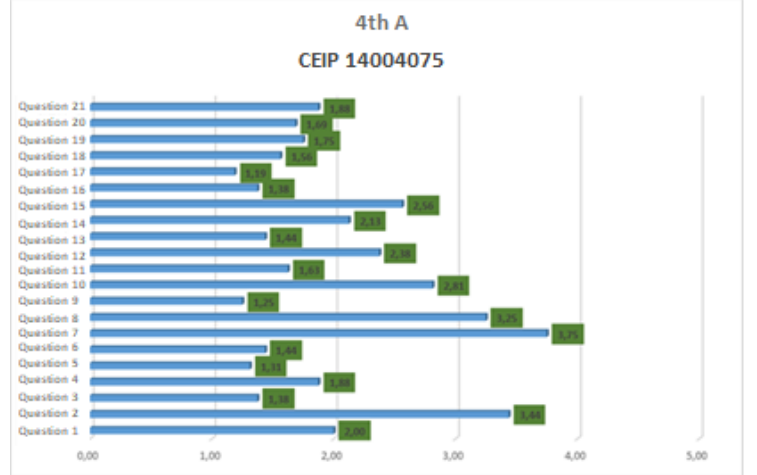
Figure 4 . Average questionnaires´ results 4 th A CEIP